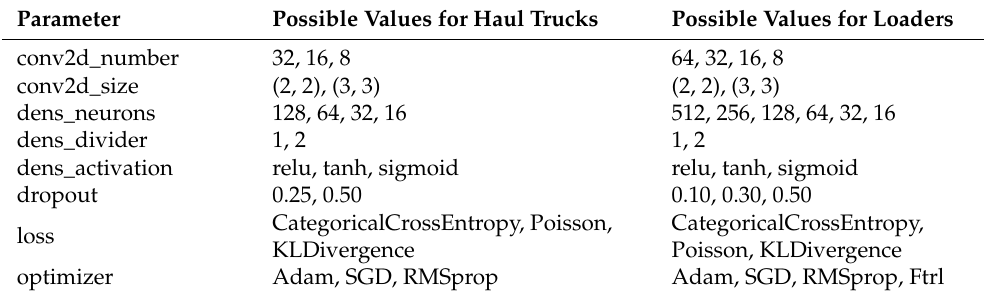
Table 3. Hyperparameter values tested during optimization process for haul trucks and loaders.